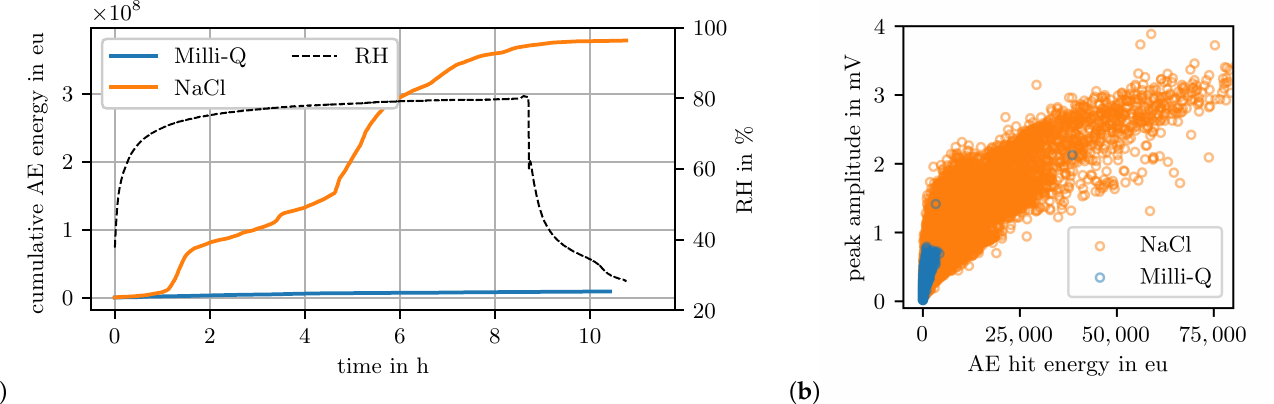
Figure 10. Results of the AE source identification experiment: ( a ) relative humidity (RH) and cumulative AE hit energy versus time and ( b ) peak amplitude versus AE hit energy caused by the droplet of Milli-Q water and the droplet of the NaCl solution,